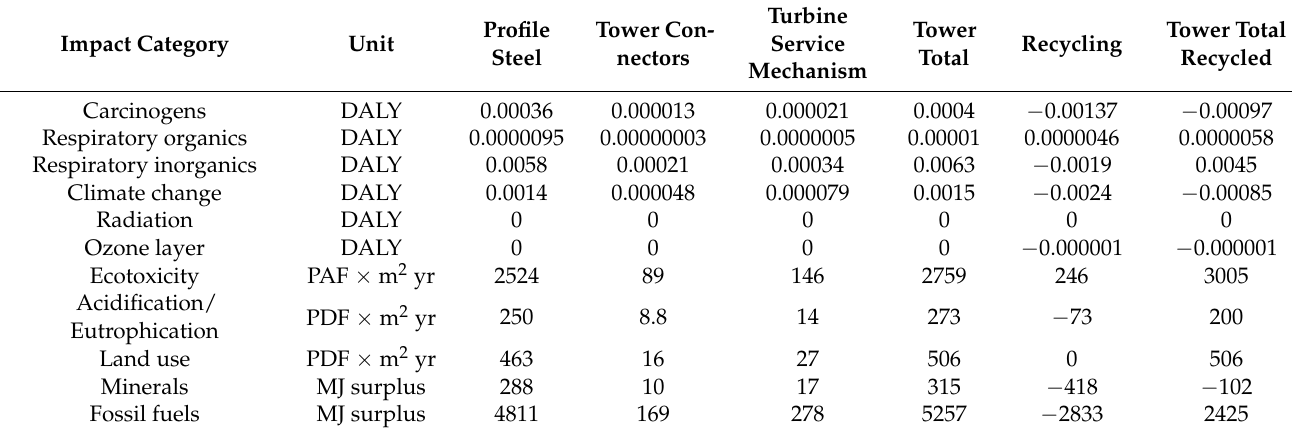
Table 4. Results of characterization of environmental impacts at the stage of production and recycling of an innovative wind turbine